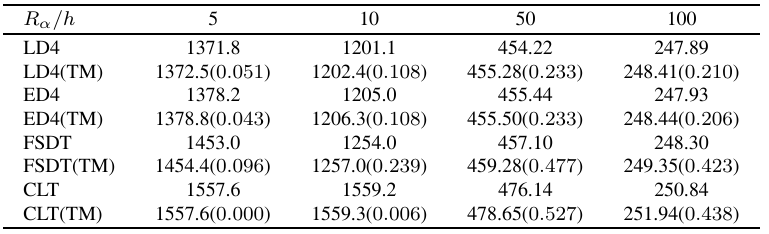
Table 6 Freevibrationsoftwo-layeredisotropicshell: fundamentalfrequency f in Hz for m = n